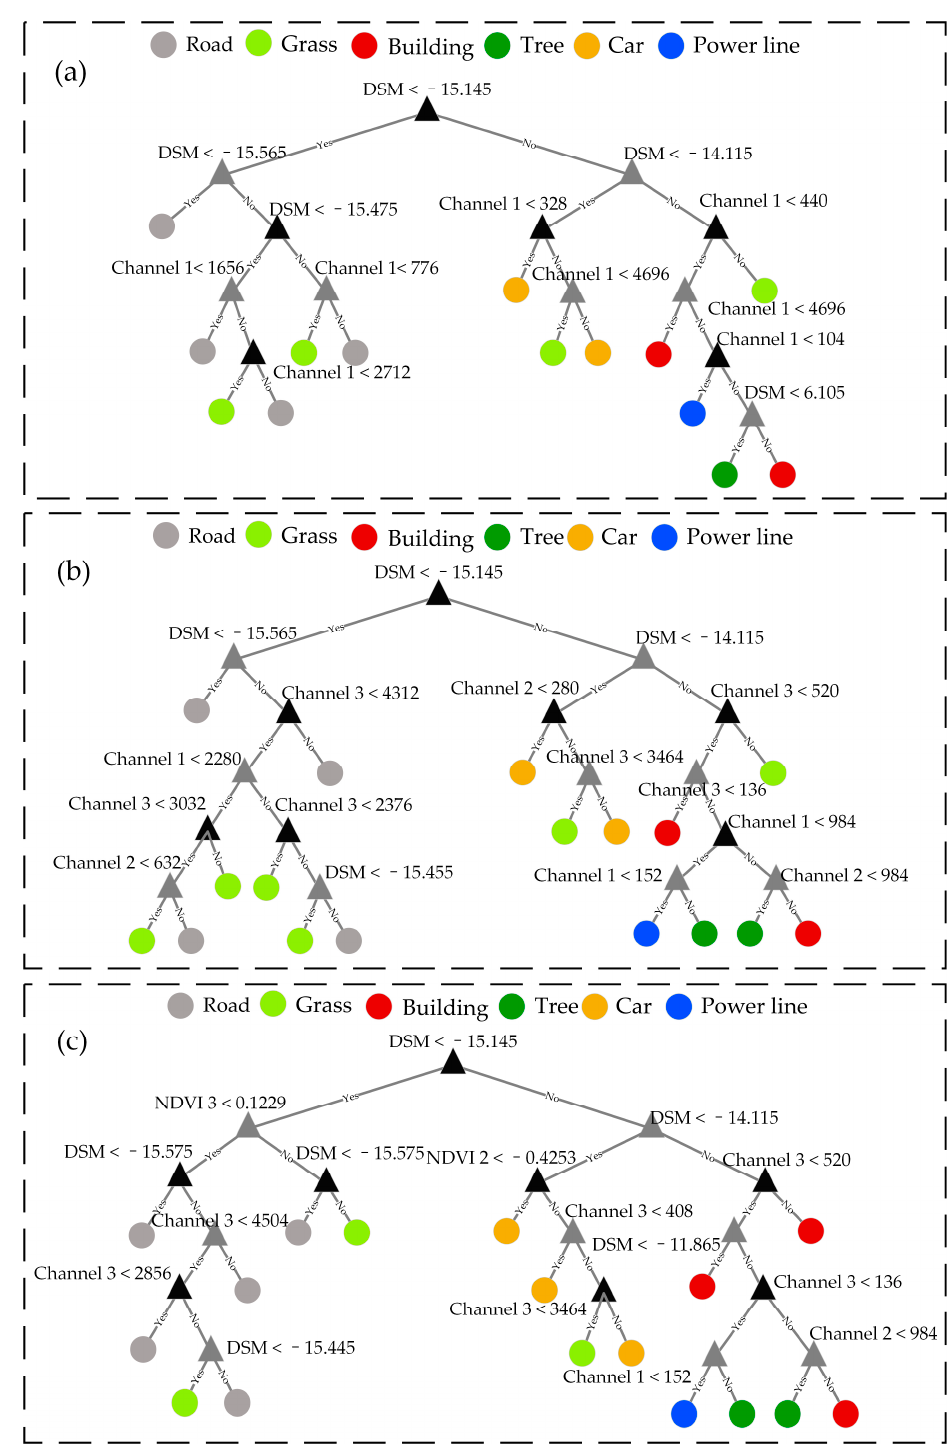
Figure 5. Three types of decision trees, partially constructed. ( a ) Method (a); ( b ) method (b); ( c ) method (c).